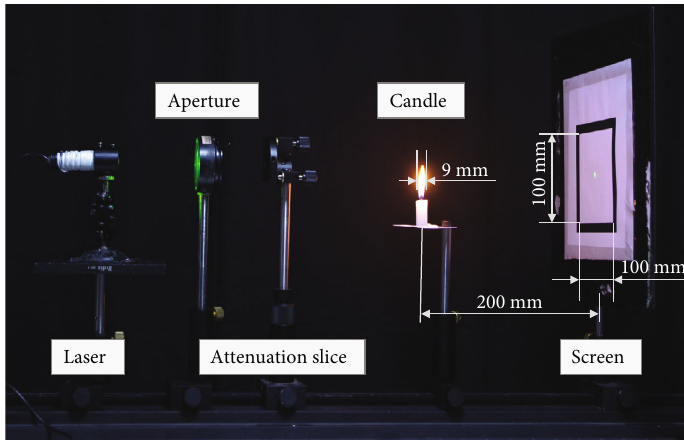
Figure 13: The experimental system of measuring the absorption and scattering coe ffi cients.